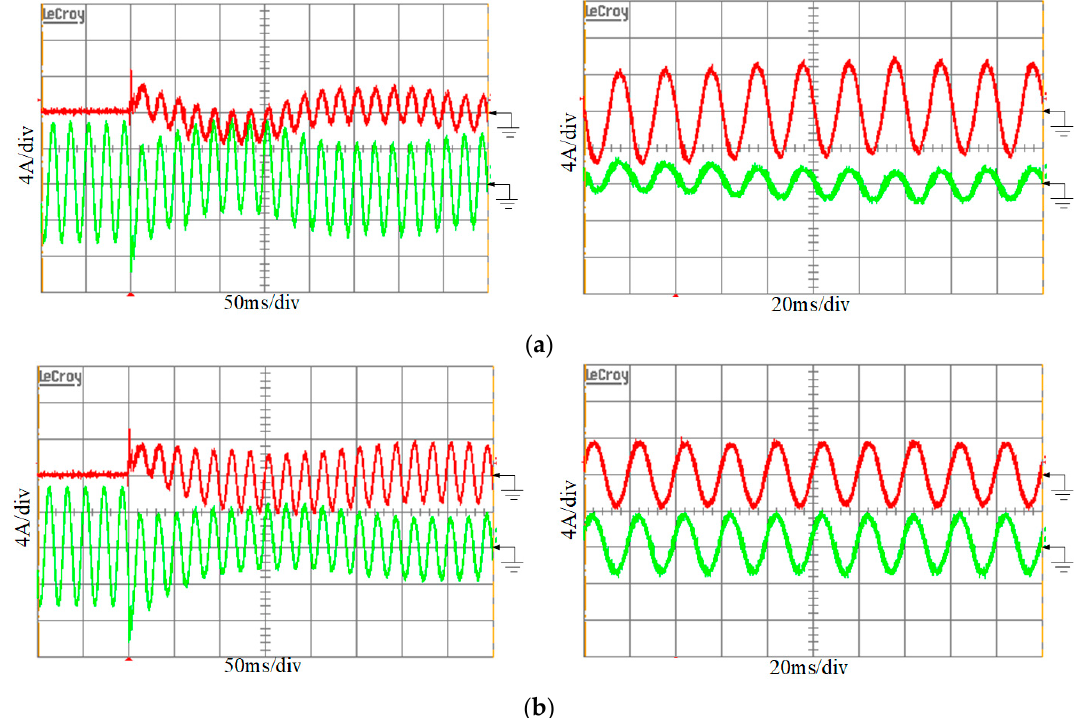
Figure 9. Output current of parallel system with SPM. ( a ) Using original K’ . ( b ) Modified K .